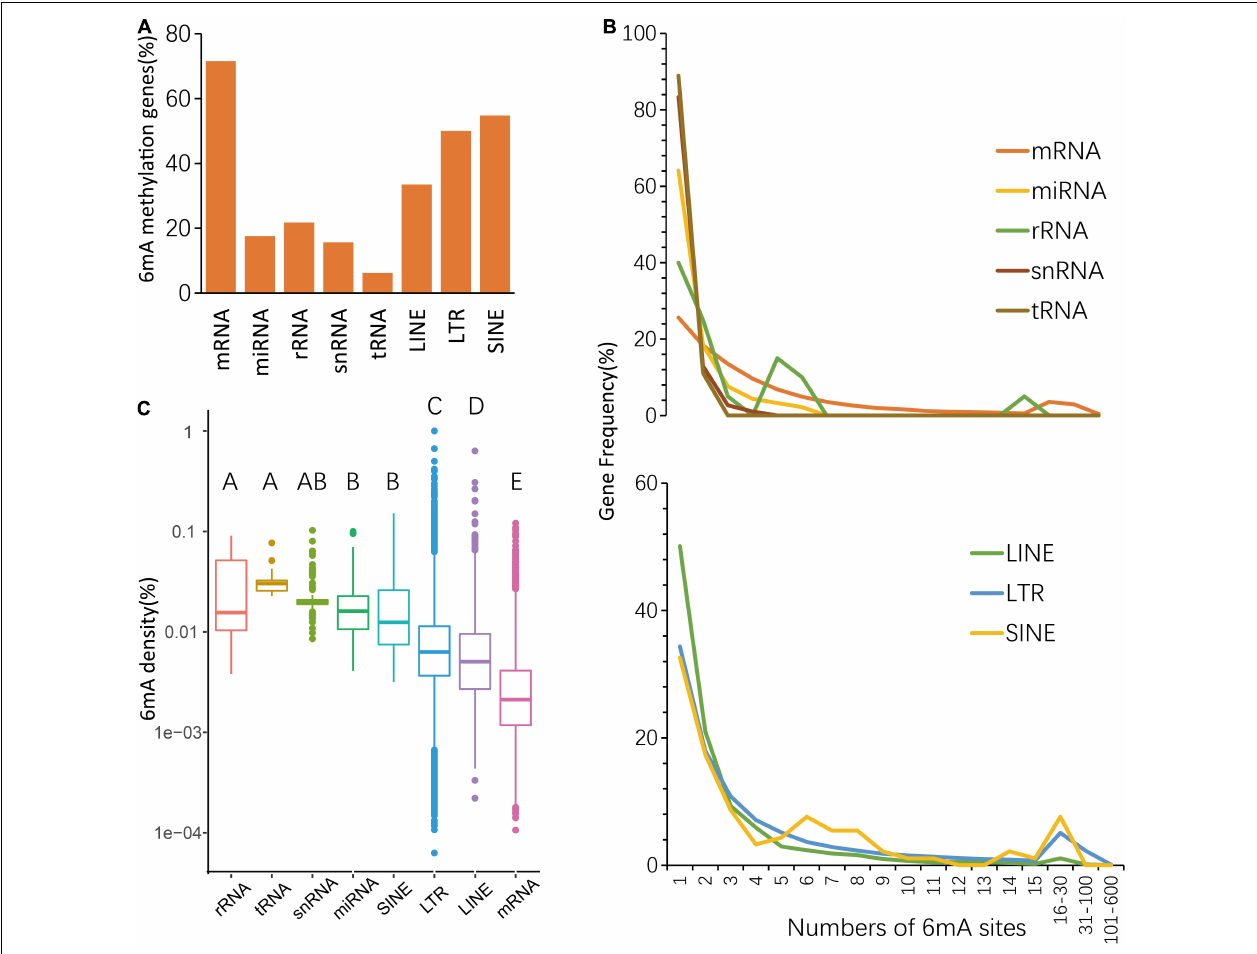
FIGURE 2 | Distribution of 6mA in echo type of genes. (A) The percentage of 6mA-methylated genes. (B) Statistics of gene numbers with different 6mA sites. (C) The different 6mA modification density in echo type of